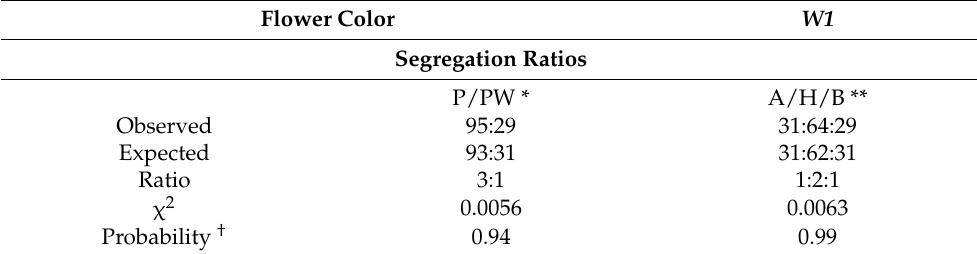
Table 1. Segregation and co-segregation